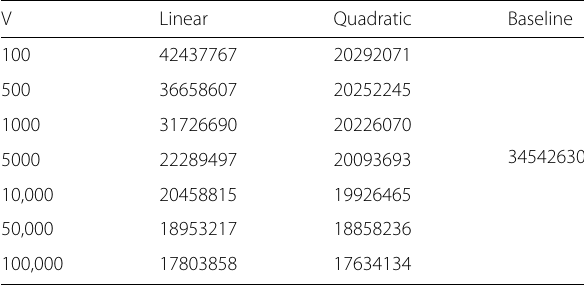
Table 1 Comparison of energy consumption in data